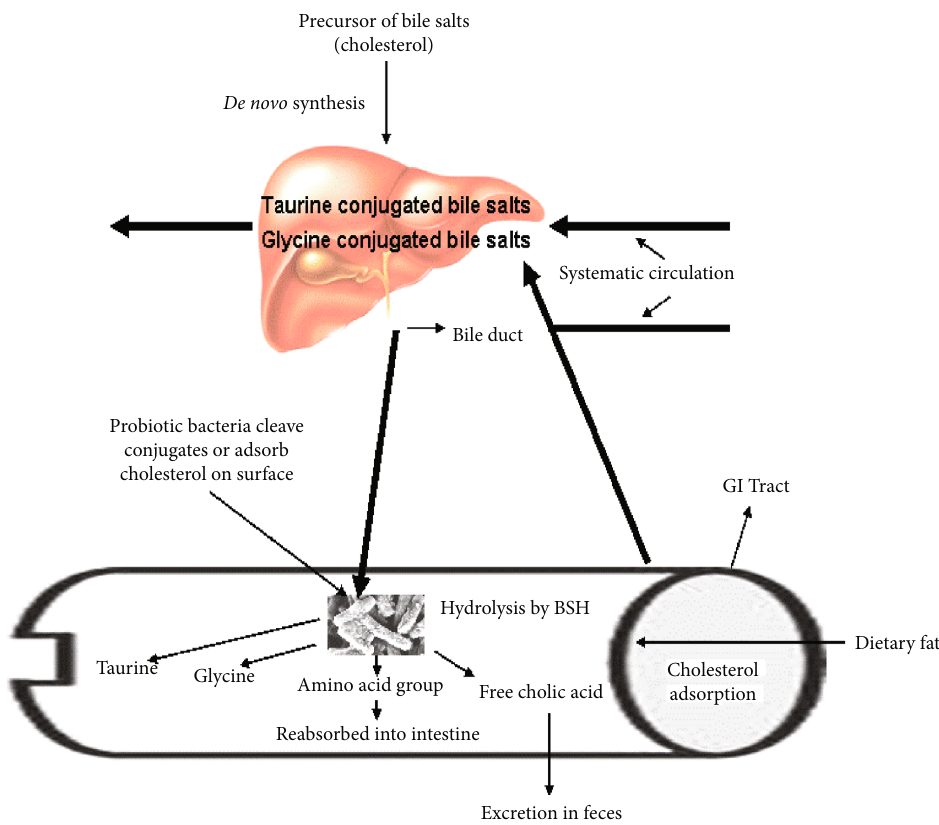
Figure 1: Illustration depicting cholesterol as a precursor for the synthesis of new bile acids and the cholesterol-lowering role of bile salt hydrolase